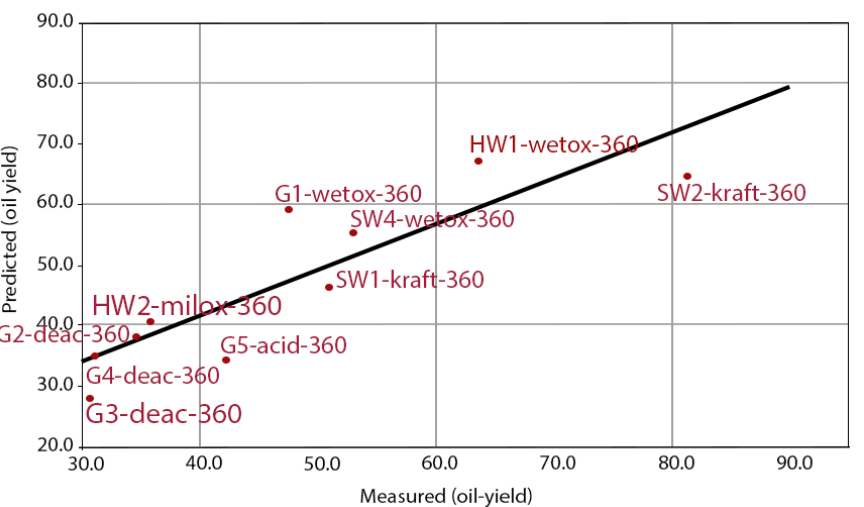
Figure 9. Multivariate regression model of predicted vs. measured oil yield based on the elemental analysis of lignin as specified in Equation (4). The regression coefficient is 0.87.